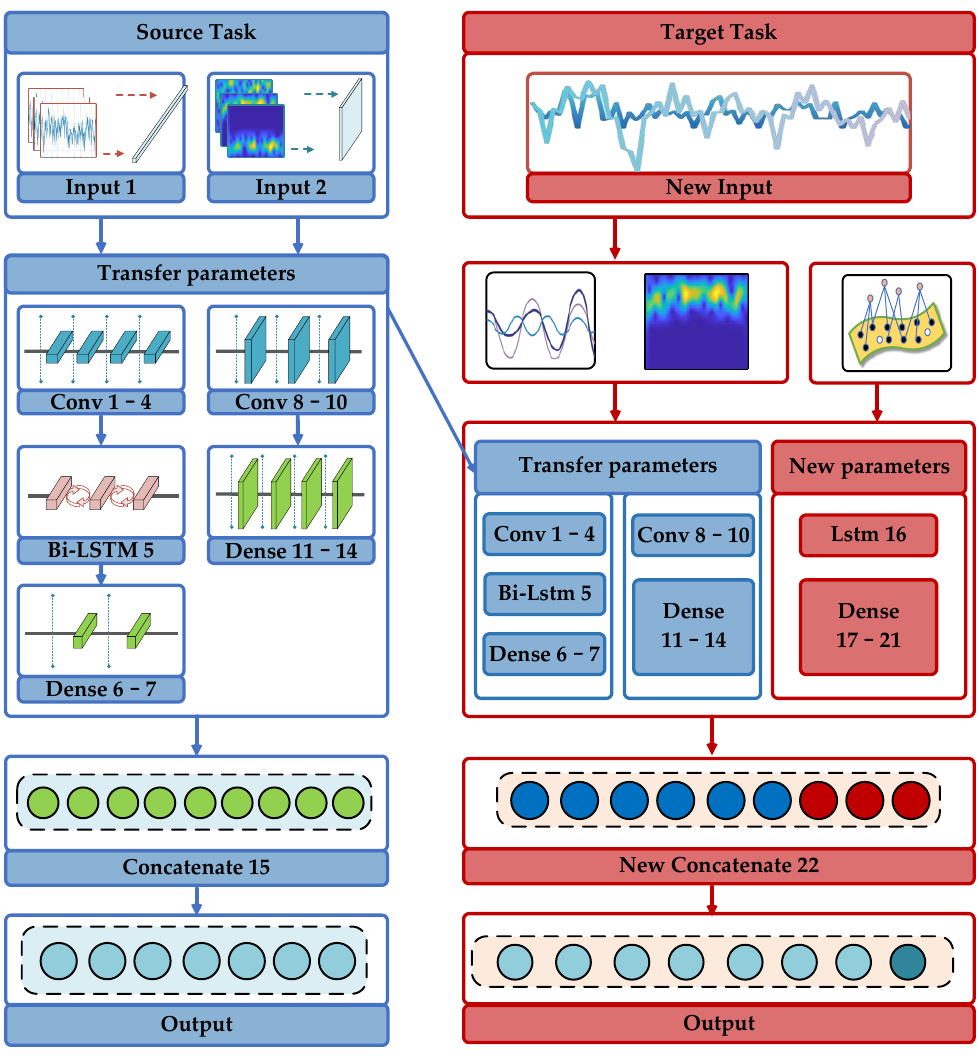
Figure 8. MJMN recognition framework.